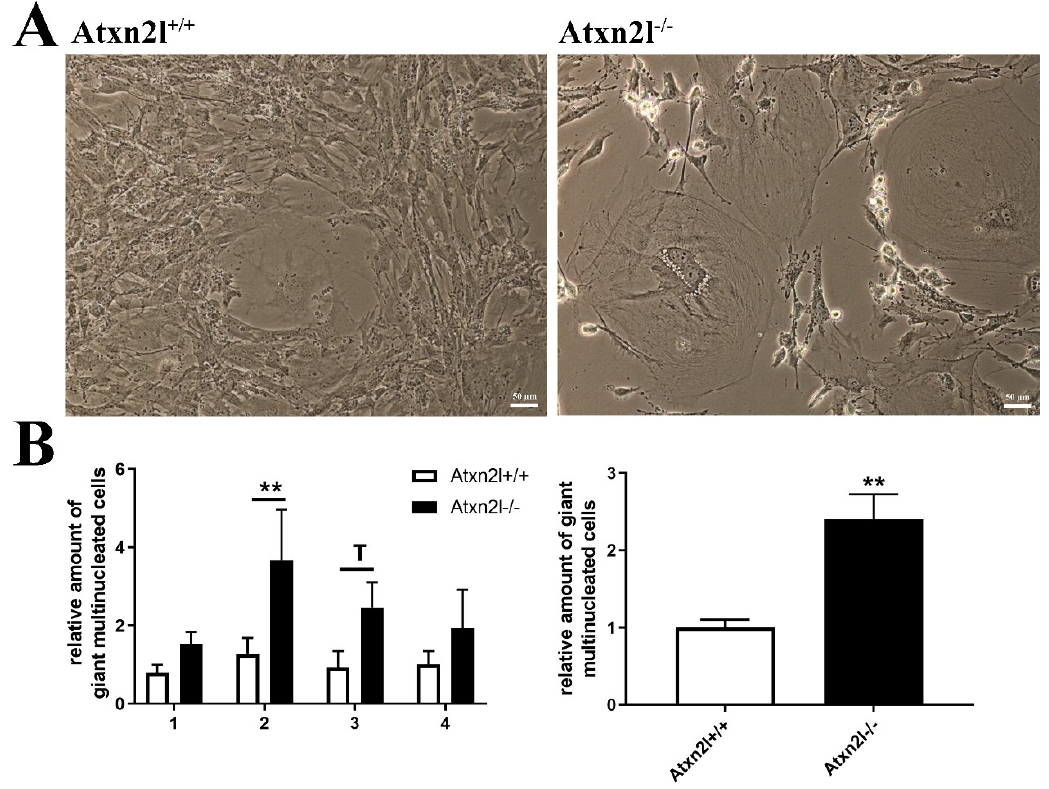
Figure 6. ( A ) Cell culture images of Atxn2l +/+ and Atxn2l − / − MEF illustrating the increased number of giant multinucleated cells in the absence of Atxn2l . ( B ) Quantification of giant cells for 4 different age- matched littermate lines with 3 technical replicates each. The diagram on the left side shows the increase with consistency for the individual MEF lines 1-4, while the diagram on the right side represents the overall increase across all lines. Statistical testing was done by two-way ANOVA and t-test with Welch’s correction, respectively, significance levels were illustrated by ** for p < 0.01, by T for 0.05 < p <0.1.